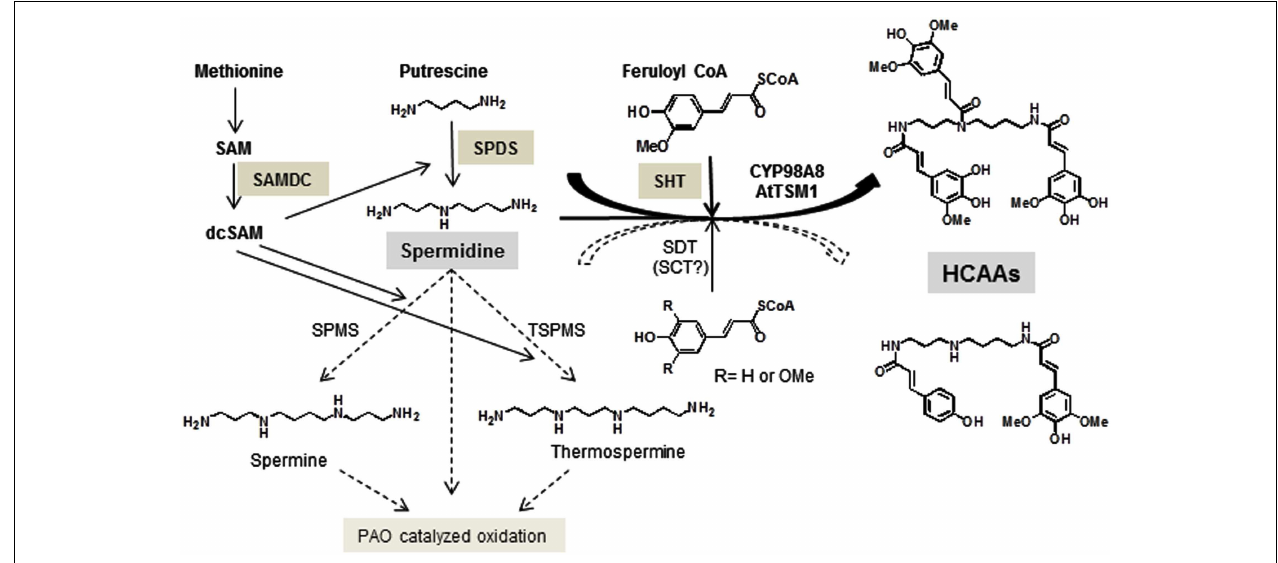
FIGURE 1 | Key steps in the biosynthetic pathway of HCAAs in Arabidopsis stamens. Relevant enzymes SAMDC, SPDS, and SHT as well as the major polyamine, spermidine are specifically marked.The presence of spermidine disinapoyl transferase (SDT) transcript levels has been confirmed in this